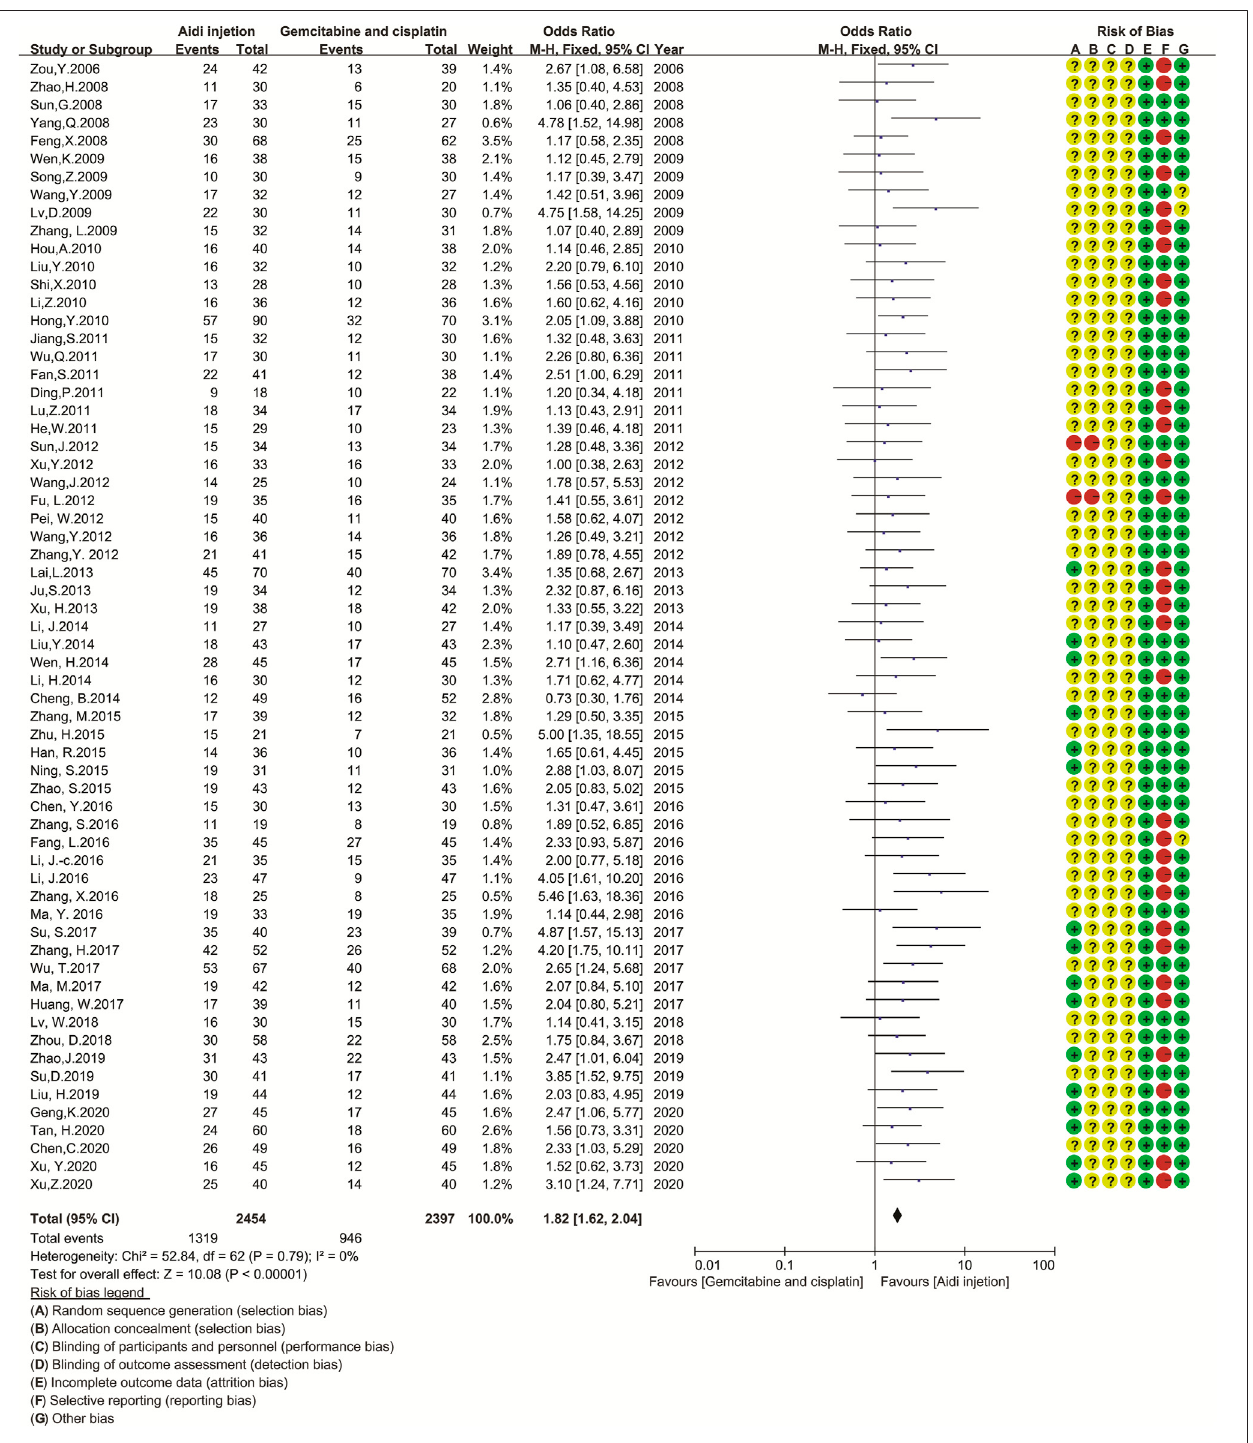
FIGURE 3 | The analysis of tumor response between two groups 3a.The analysis of ORR between two groups. The pooled result showed a signi fi cant improvement in ORR in the Aidi and GP combination group compared to that in the control group (OR (cid:1) 1.82, 95% CI [1.62 to 2.04], p < 0.00001). Note: GP, Gemcitabine, and cisplatin;ORR, objective responserate.3b. The analysis ofDCR between two groups. The pooled result showed a signi fi cantimprovement in DCR in the Aidi and GP combination group compared to that in the control group (OR (cid:1) 2.29, 95% CI [1.97 to 2.67], p < 0.00001). Note: GP, Gemcitabine, and cisplatin; DCR, disease control